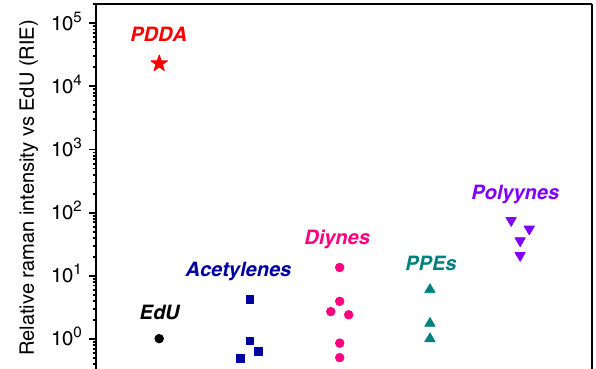
Fig. 4 Plot of C ≡ C bond-normalized RIE values of various types of alkynes. The detailed information of each data point, including RIE value, chemical structure, Raman shift, and resource, is available in Supplementary Table